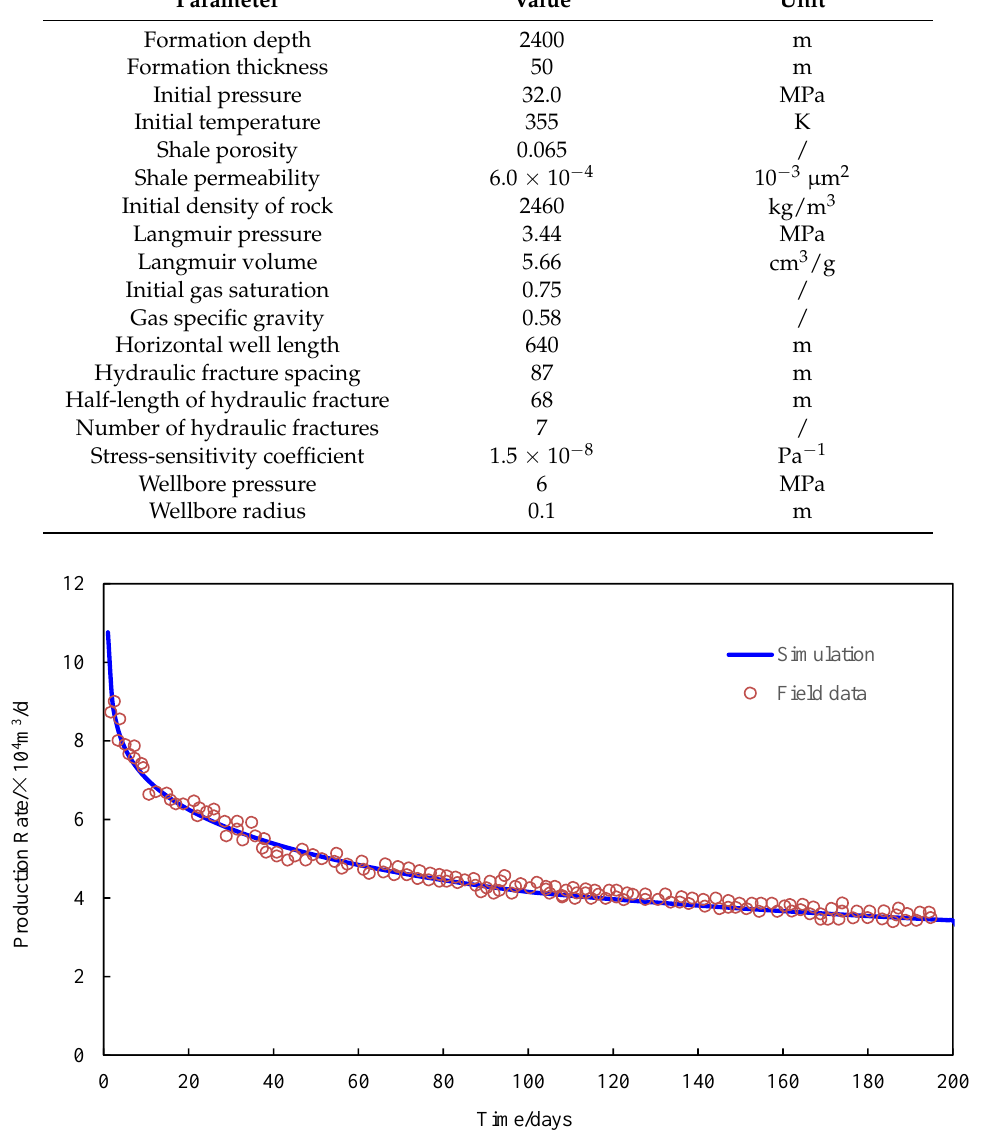
Figure 7. The match result of gas production rate for shale gas reservoirs with field date.